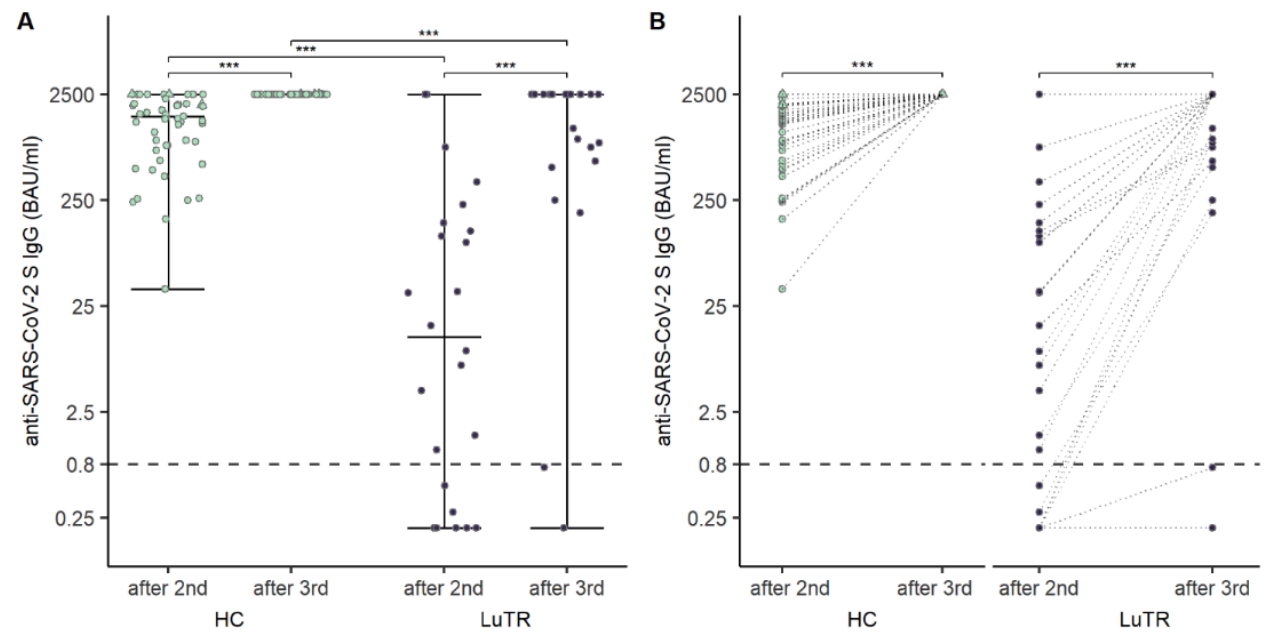
Figure 3. Humoral response in LuTRs and in HCs 4 weeks after the second and the third dose of vaccination: SARS-CoV-2 S antibody levels (BAU/mL) ( A ), and change in SARS-CoV-2 S antibody levels (BAU/mL) after second and third immunization ( B ). The horizontal lines indicate the cutoff for seroconversion. Circles represent individual antibody titers. Participants with a history of COVID-19, prior to immunization, are presented as triangles. Darker lines indicate overlapping points. (*** significant).